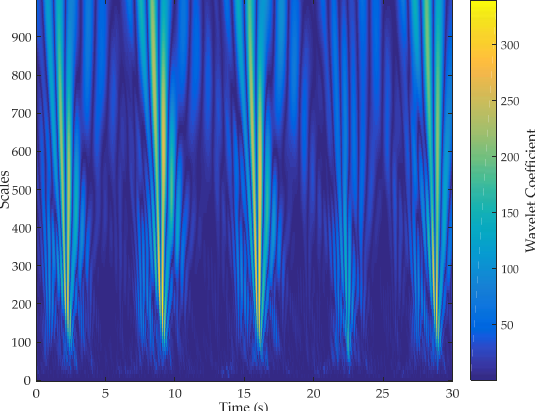
Figure 2. Wavelet coefficient of multiple scales of channel state information.